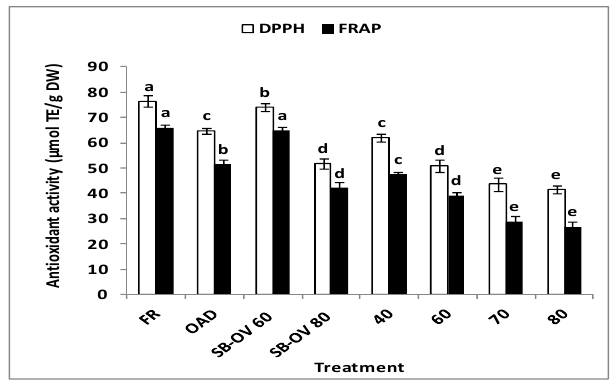
Figure 2. Effect of treatment condition on the antioxidant capacity of litchi pericarps evaluated by DPPH and FRAP assays. (FR: Fresh pericarp, OAD: Open air drying, SB-OV: Combined steam blanching and hot air oven drying. Means within a series between the bars with similar letters were not significantly different ( p > 0.05). Data were mean ± SD, n = 3).